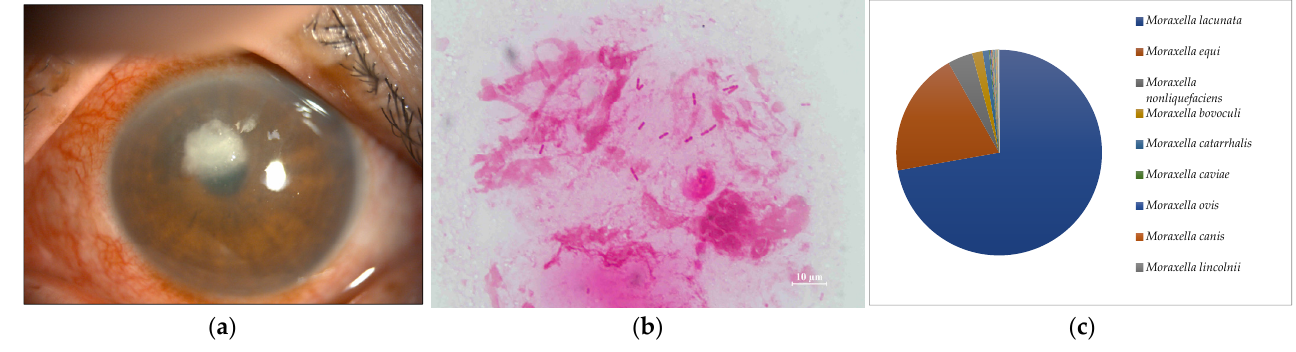
Figure 2. ( a ) Anterior segment photograph. A paracentral corneal abscess is present. ( b ) Smear microscopy. Several large Gram-negative rods were detected. ( c ) Nanopore sequencing results (relative abundance) of Case 2. Moraxella lacunata was detected as the dominant species by MinION.